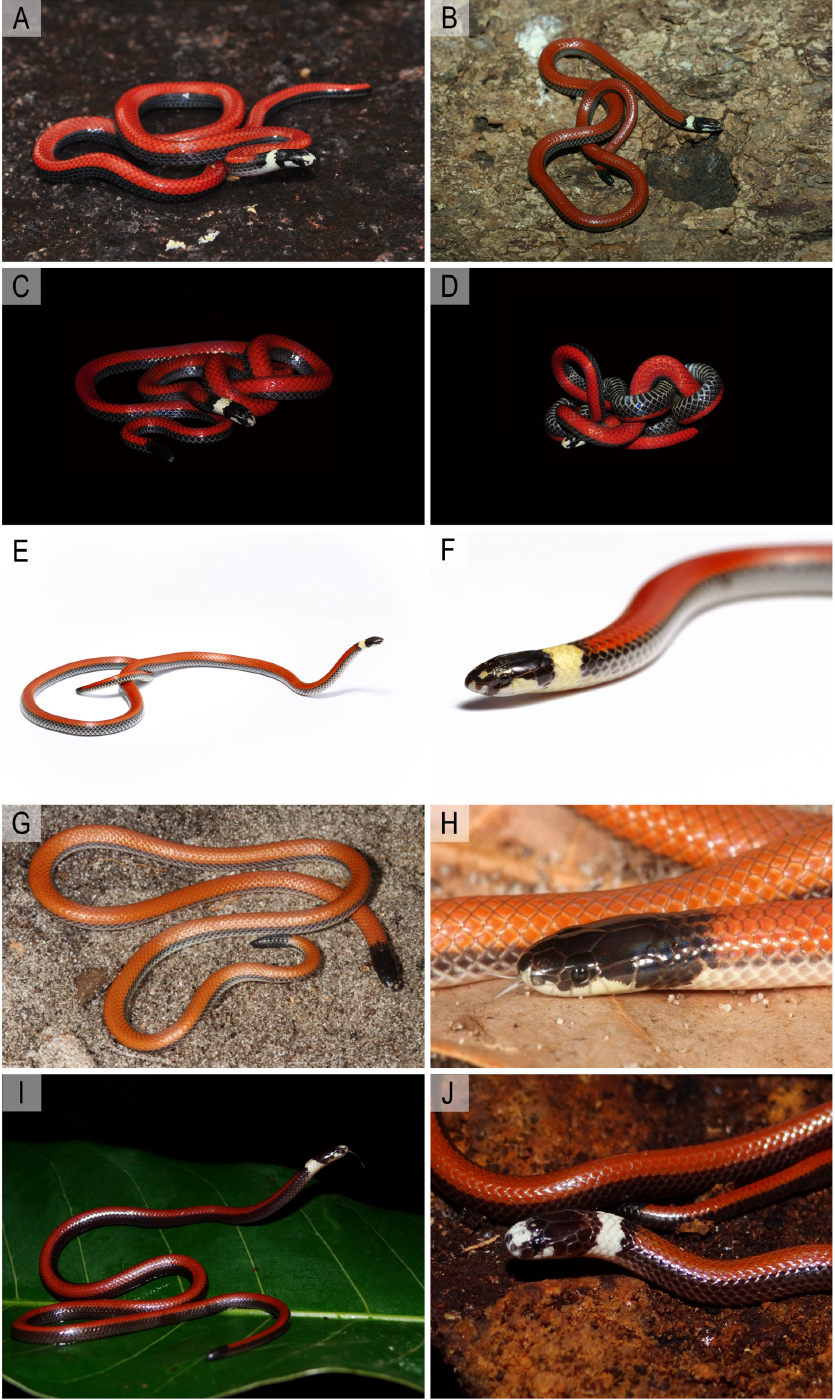
Fig. 4. Similar red species of Apostolepis Cope, 1862. A–F . Apostolepis albicollaris Lema, 2002 in life, adult individuals from Brasília, Distrito Federal, Brazil. G–H . Apostolepis dimidiata (Jan, 1862) in life, adult individual from Laguna Blanca, San Pedro, Paraguay. I–J . Apostolepis quirogai Giraudo & Scrocchi, 1998 in life, adult individual from Misiones, Argentina. Photograph credits: Cyro de Sousa Bernardes (A, C–D), Luís Felipe Carvalho de Lima (E–F), Jean-Paul Brouard (G–H), Amado Martínez (I–J), and Gabriel Horta